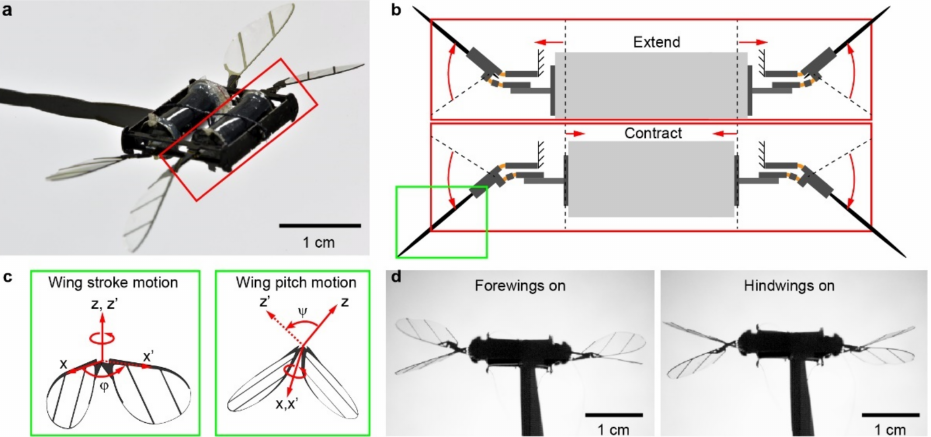
Figure 2. Design of an at-scale soft robotic dragonfly. ( a ) Perspective view of the 317 mg robot. The robot has two DEAs and each independently drives a pair of wings. ( b ) A DEA extends or contracts in response to a high-voltage driving signal. The two ends of the DEA connect to linear four-bar transmissions, which converts the DEA’s translational motion into the rotational wing stroke motion. ( b ) corresponds to the red inset shown in ( a ). ( c ) The DEA directly controls the wing stroke motion ( φ ), and the wing pitch rotation ( ψ ) is passively mediated by a compliant wing hinge. ( c ) corresponds to the green inset shown in ( b ). ( d ) The two DEAs can be actuated independently. The two high-speed camera images show experiments in which either the forewings ( left ) or the hindwings ( right ) are turned